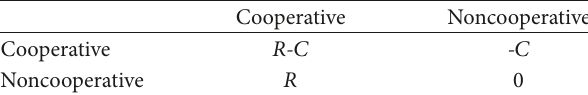
Table 1: Profit matrix of forwarding packets.